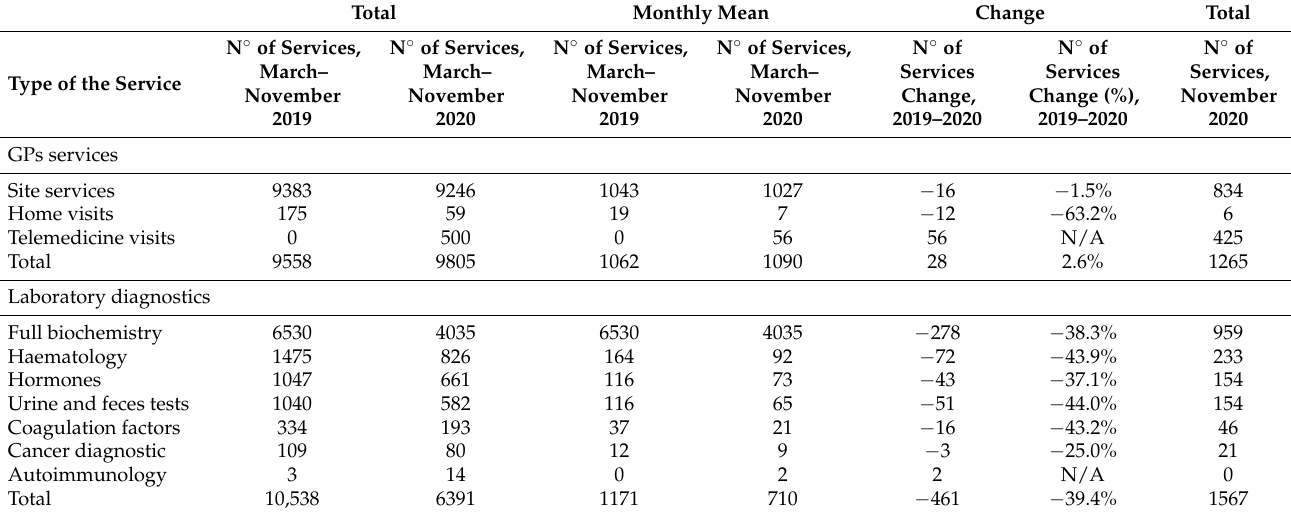
Table 6. Number of GPs services and laboratory diagnostics provided to the patients of Clinic 2 in March–November